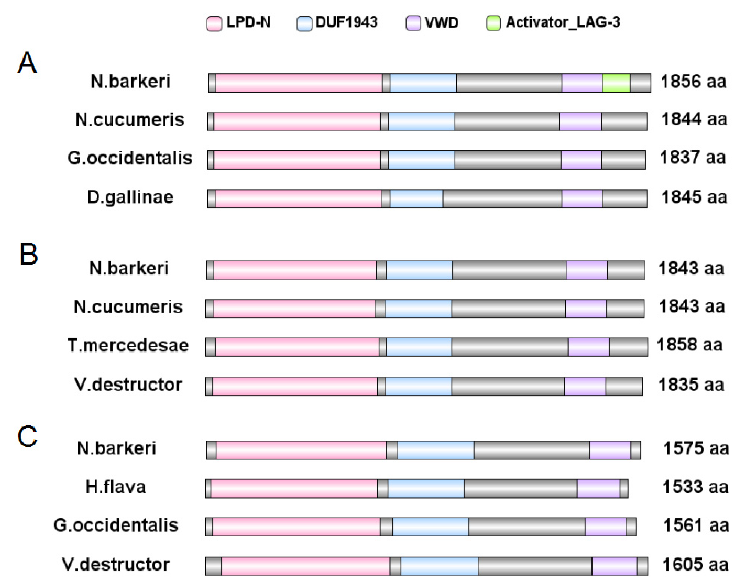
Figure 5. Schematic comparison of the primary protein structures of N. barkeri vitellogenin (Vg) with those of other mite or tick species. ( A ) Comparison of NbVg1 gene domains against those of other mite Vg genes. ( B ) Comparison of NbVg2 gene domains against those of other mite or tick Vg genes. ( C ) Comparison of NbVg3 gene domains against those of other mite or tick Vg genes. VWD, Von Willebrand factor D domain; DUF, unknown functional domain; LPD_N, Lipoprotein N-terminal Table 2. Primary structure analysis of NbVg1, NbVg2, NbVg3, and NbVgR. Protein Amino acids Molecular weight (kDa) Theoretical pI Nb Vg1 1856 212